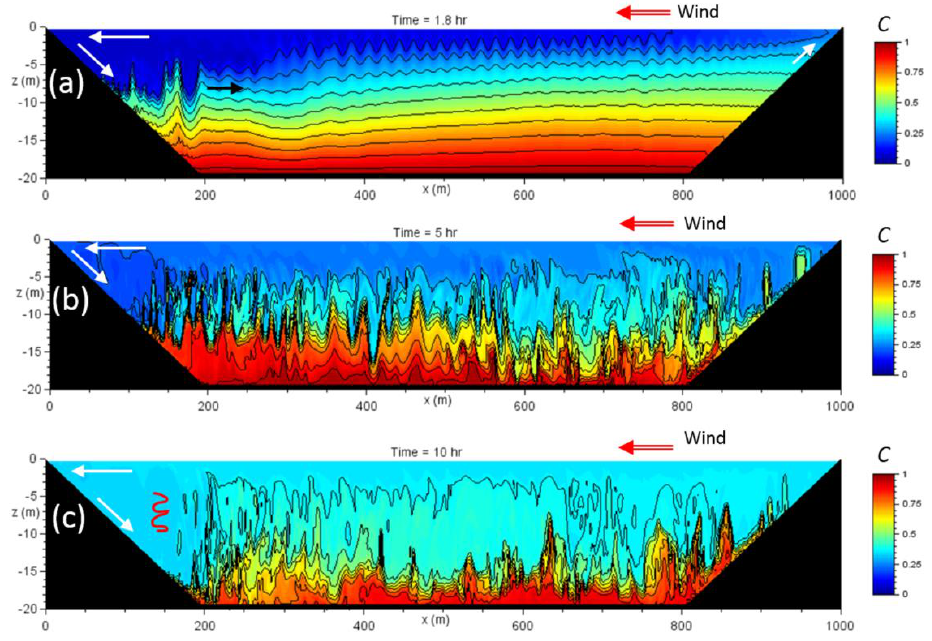
Figure 8. Same as Figure 4, but for Scenario B with τ x = − 0.1 Pa and N 2 = 2 × 10 − 4 s − 2 . Shown is the evolution of the concentration field C after ( a ) 1.8 h, ( b ) 5 h and ( c ) 10 h of simulation. See GIF Animation S2 for a simulation of this